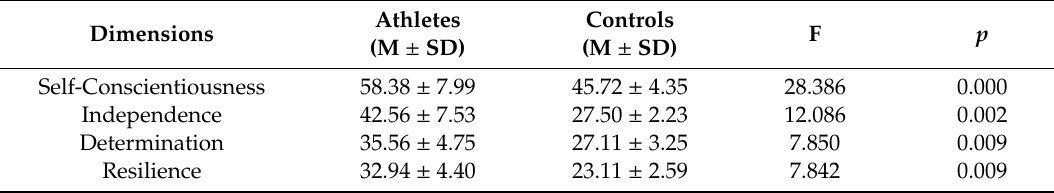
Table 2. Group di ff erences in dimensions of volitional